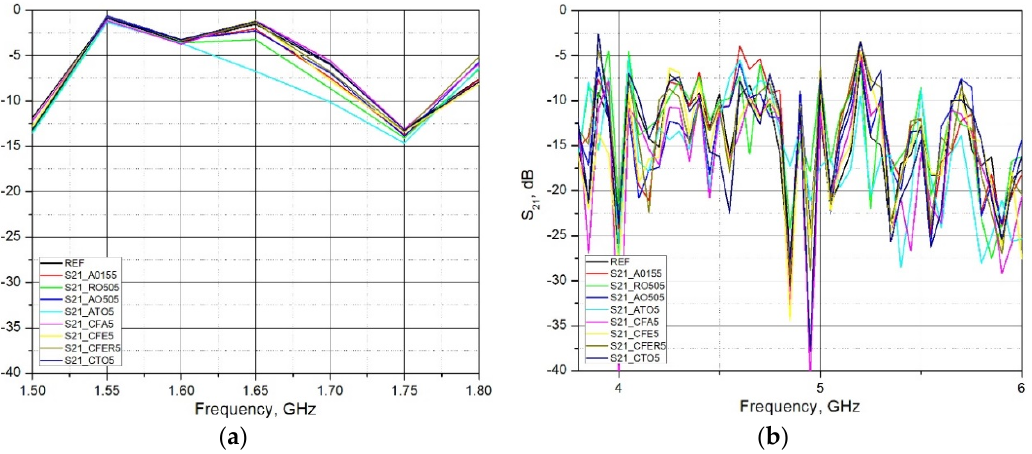
Figure 11. Measured S 21 parameter of brick samples for ( a ) frequency range 1.50 to 1.80 GHz; and ( b ) frequency range 3.80 to 6.0 GHz, (d = 18 mm; 2r = 150 mm) .